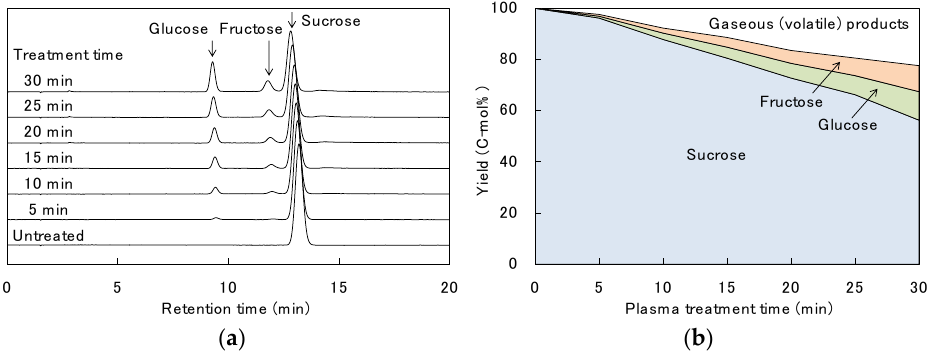
Figure 2. Products in the sample solutions after solution-plasma treatment of sucrose (sucrose, 10 g/L; electrode distance, 2.4 mm; average power, 34.2 W). ( a ) HPAEC chromatograms. ( b ) Product yields based on the moles of carbon atoms in the initial